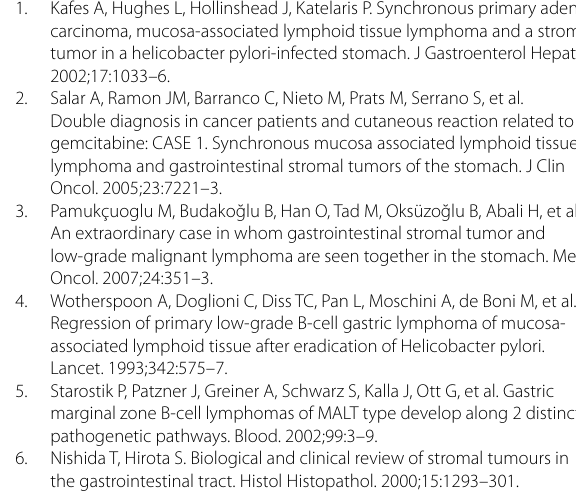
100). B × 200). C Gastrointestinal ×